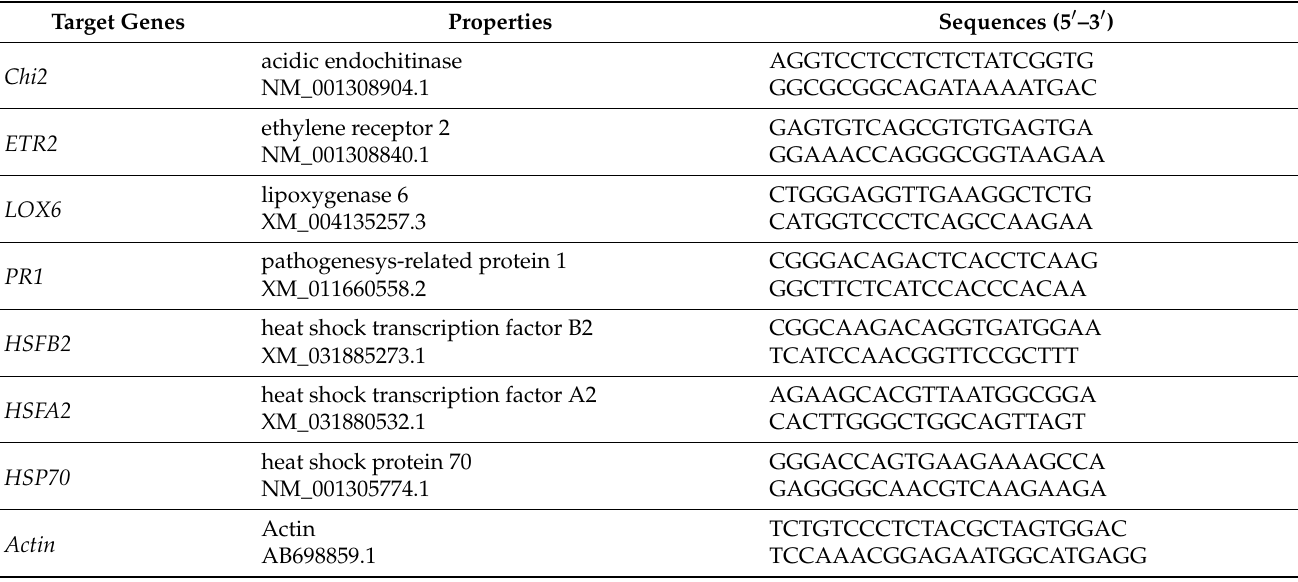
Table 1. Primers used for the amplification of cucumber genes related to pathogen resistance and heat